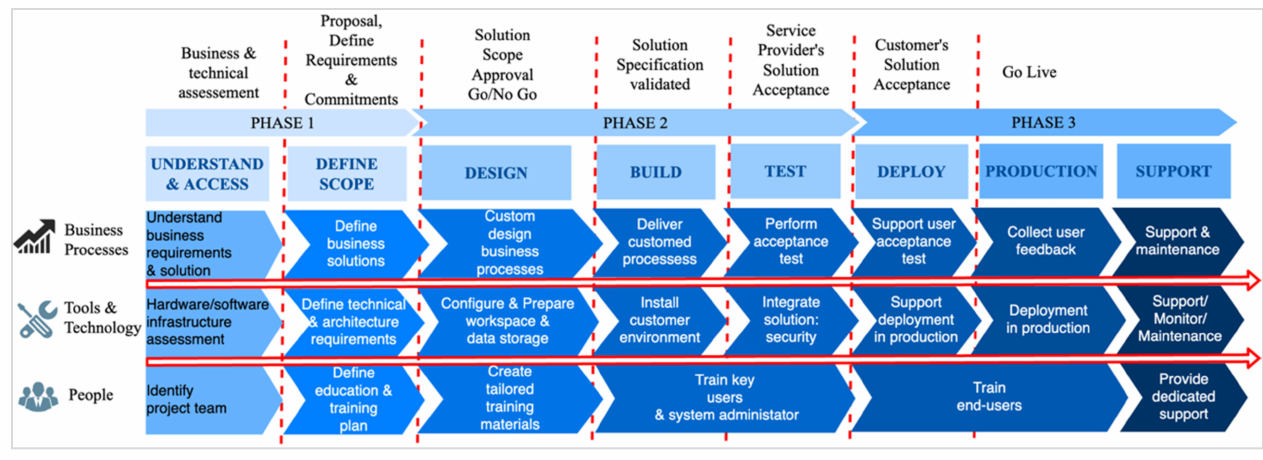
Figure 12. Design, build and implementation of the ‘out-of-the-box’ digital twin/thread product roadmap (modified from